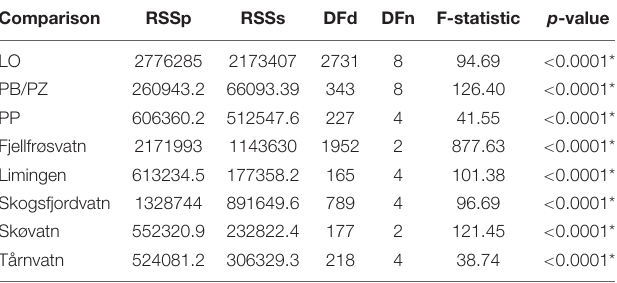
TABLE 4 | Likelihood Ratio Test p -values from pairwise comparisons testing for differences when parameters r or c were kept constant in the LO morph (top), PB/PZ (mid), and PP (bottom).